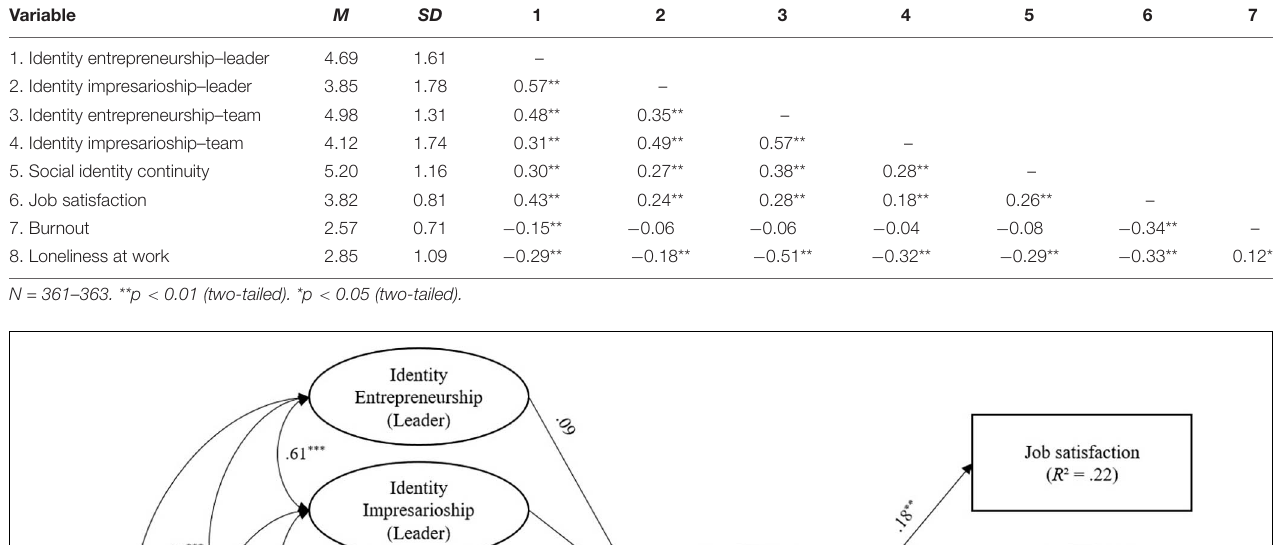
TABLE 2 | Descriptive statistics and correlation coefficients. Variable